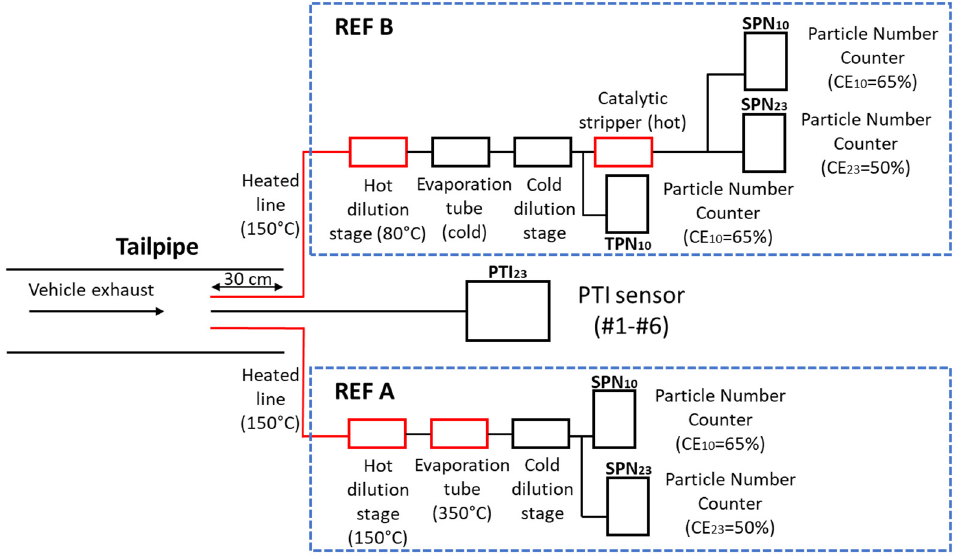
Figure 1. Schematic of the experimental setup. In red we show heated parts. Either ‘REF A’ or ‘REF B’ setups were employed while SPN-PTI sensors #1 to #6 were measuring sequentially.